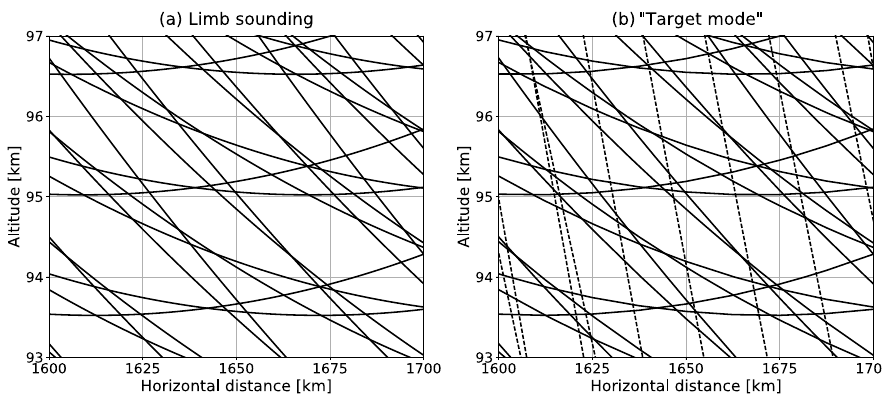
Figure 2. Central measurement track of an imaging instrument in the pure limb sounding and “target mode”. The solid lines represent limb measurements and dashed lines represent sub-limb measurements. The satellite viewing geometry of (b) is the same as in Fig. 1.